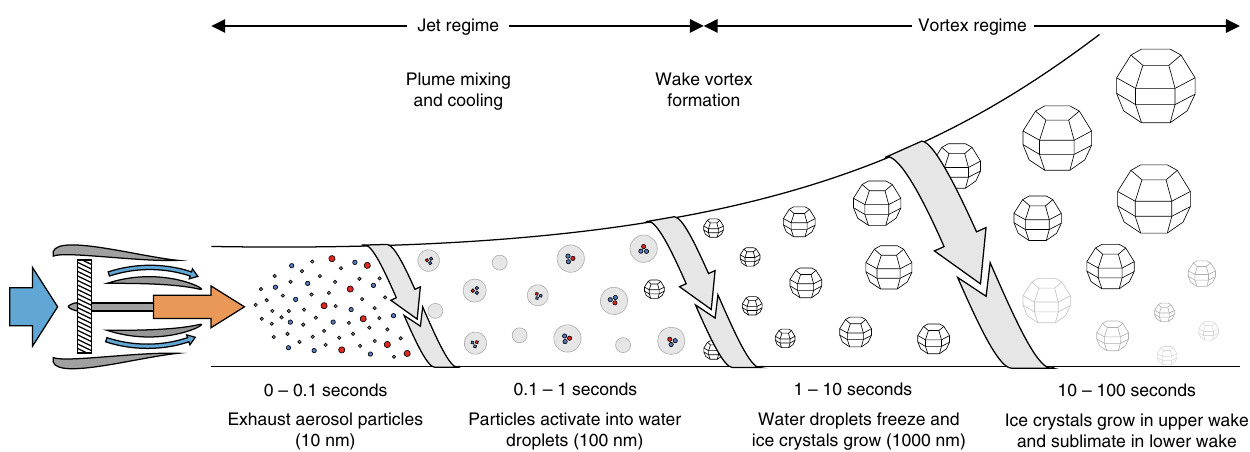
Fig. 2 Processes in fl uencing the contrail formation stage. Exhaust plumes produced by combusting fuel – air mixtures at high temperature and pressure within turbofan jet engines contain gaseous and particulate matter. Particles types present in the freely expanding and cooling plumes (jet regime) comprise emitted soot particles and aqueous aerosol particles formed in the exhaust (Box 1) along with entrained ambient aerosol particles. When turbulent mixing (arrows) and the associated cooling produces plume supersaturation over liquid water ( s w > 0), copious plume particles turn into water droplets (grey) that freeze and grow rapidly by uptake of water vapour forming a visible contrail. This happens when the ambient temperature, T , falls below the formation threshold, Θ . In soot-rich exhaust, most droplets contain soot inclusions. Droxtals, frozen water droplets with faceted surfaces, and hexagonal prisms and columns likely developing from them may provide a realistic representation of small ice crystals in fresh contrails, but no direct observational evidence for their shapes is available. Plumes from multiple aircraft engines merge with two wing tip vortices, forming an inhomogeneous wake. The further evolution of ice crystals depends largely on fl uid-dynamical processes (vortex regime). The downward motion of the vortex pair warms the air causing ice crystal sublimation in the lower part of the wake. A small contrail fraction is released from the jets remaining at fl ight level and enhanced by detrainment of air from the lower wake. Ice crystals present in the upper wake continue to grow by uptake of entrained ice-supersaturated ( s i > 0) ambient water vapour. Few minutes past emission, the organised fl ow pattern collapses and mixes with ambient air (dissipation regime). Ice crystal images adapted from ref. 141 with permission from The Optical Society of America